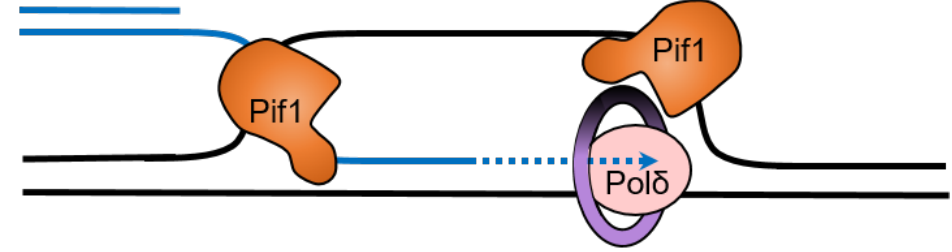
Figure 6. Pif1 promotes break induces replication with Polδ and PCNA. A second Pif1 may unwind the nascent strand to resolve the D-loop and reduce topological stress.